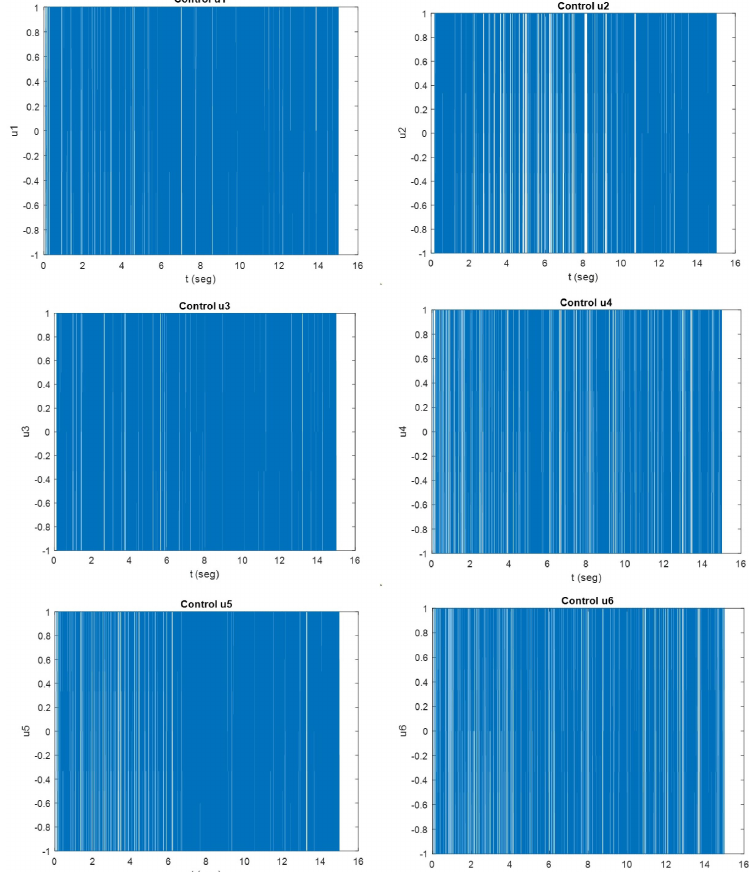
Figure 16. Signal of control applied to the physical